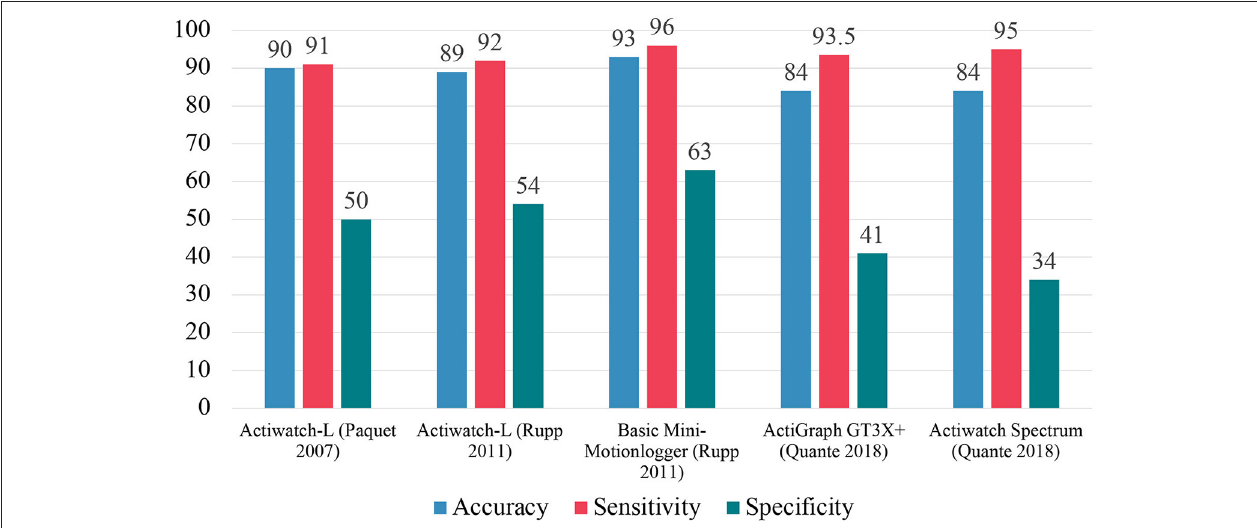
FIGURE 3 | Summary of EBE analysis of standard actigraphic devices. Accuracy measures the overall ability of a device to correctly classify epochs as either sleep or wake, sensitivity measures ability to classify sleep epochs, and specificity measures ability to correctly classify wake epochs.